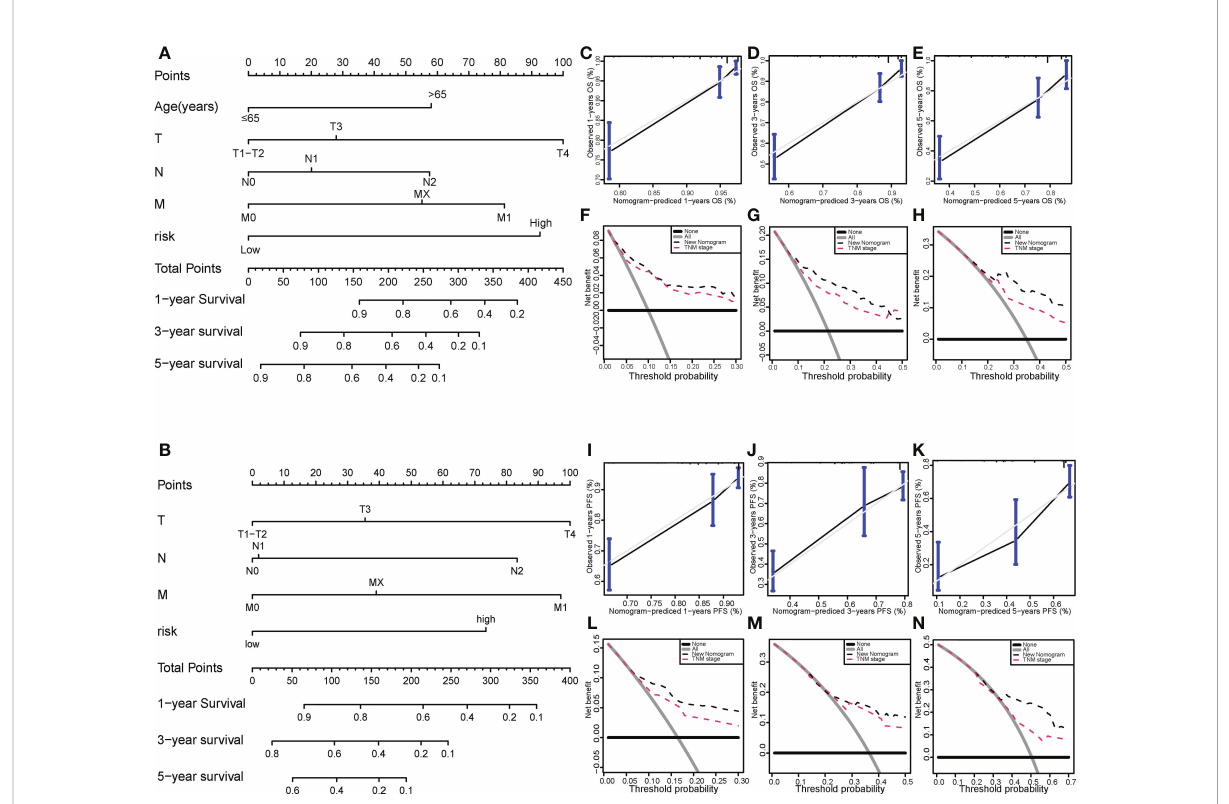
FIGURE 7 Nomogram model for colon cancer in the TCGA cohort. Nomogram models to predict the 1-, 3-, and 5-year OS rates (A) and PFS rates (B) of colon cancer cases. Calibration graphs indicate that the predicted 1- (C) , 3- (D) , and 5-year (E) OS rates correspond with the actual OS rates. DCA showing the net bene fi t of our prognosis model and the TNM staging model in the predictive models of 1- (F) , 3- (G) , and 5-year OS rates (H) . Calibration graphs indicate that the predicted 1- (I) , 3- (J) , and 5-year (K) PFS rates correspond with the actual PFS rates. DCA showing the net bene fi t of our prognosis model and the TNM staging model in the predictive model of 1- (L) , 3- (M) , and 5-year PFS rates (N) . TCGA, The Cancer Genome Atlas; DCA, decision curve analysis; OS, overall survival; PFS, progression-free